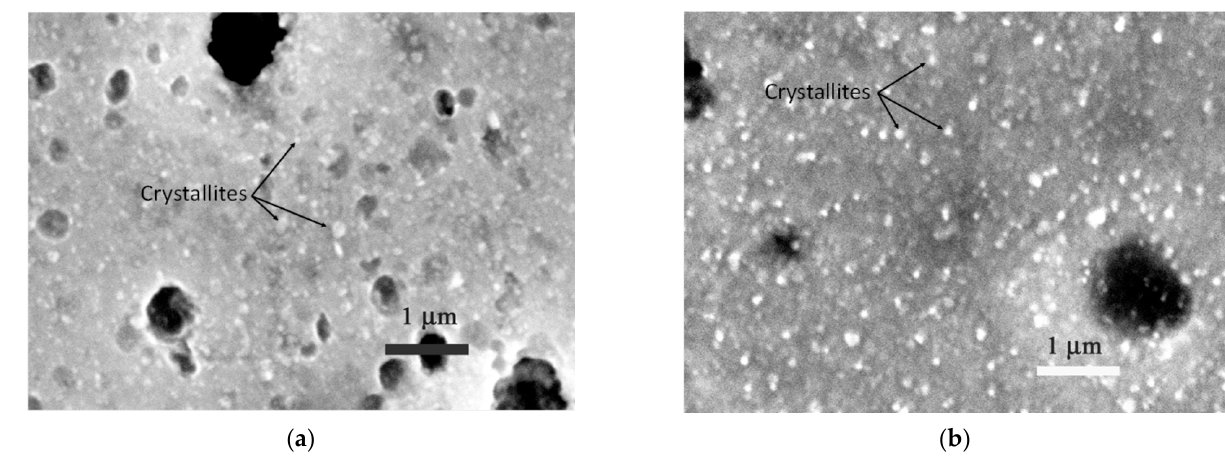
Figure 6. SEM microstructural image of ( a ) Alps and ( b ) 75/0s samples.